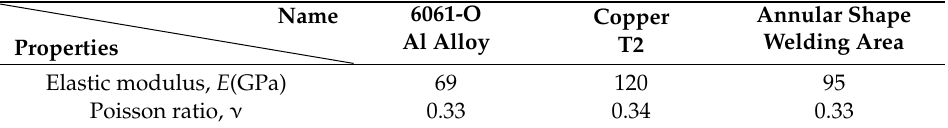
Table 3. Young’s modulus and Poisson ratio of 6061-O Al alloy and